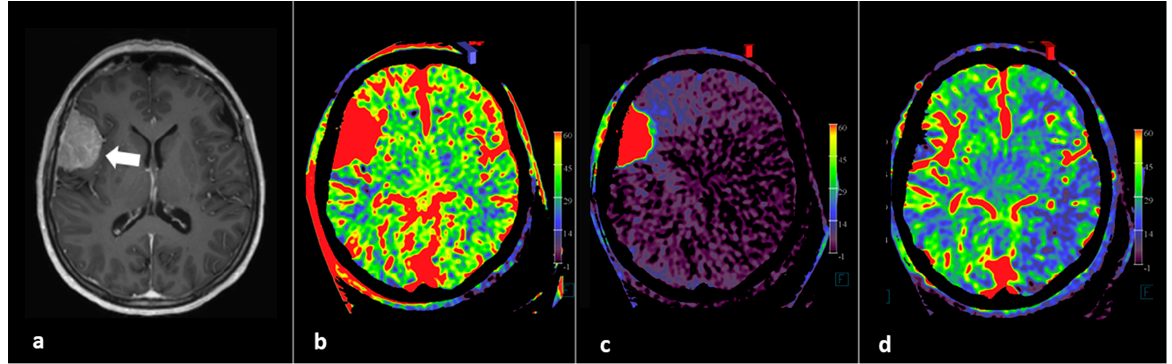
Figure 3. FD CT PBV imaging in a patient referred for pre-operative tumor embolization. ( a ) Axial T1-WI image shows right-sided perisylvic meningioma (arrow). ( b ) Pre embolization axial PBV MIP reformation after aortic root contrast demonstrating whole brain PBV imaging. ( c ) Pre embolization axial PBV MIP reformation with right external carotid artery (ECA) contrast injection demonstrates dominant dural vascular tumor supply. ( d ) Post embolization whole brain PBV axial MIP reformation illustrates successful tumor embolization.